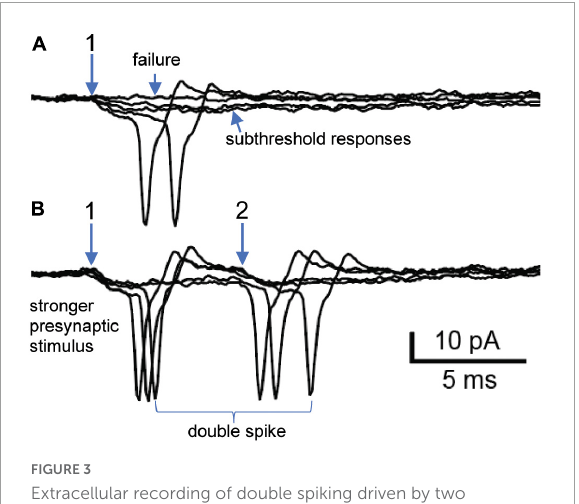
FIGURE3 Extracellular recording of double spiking driven by two straddling synapses. (A) Selective activation of synapse 1. Five responses at synapse 1 include 2 subthreshold responses, 2 suprathreshold responses and 1 stimulus failure. Traces taken from a larger trial at 1 Hz (see text for description of all responses). (B) Raising the presynaptic stimulus strength recruited synapse 2 and eliminated failures at synapse 1. Note that synapse 2 also straddled threshold by generating subthreshold and suprathreshold responses. Experiment 6/2/16 cell